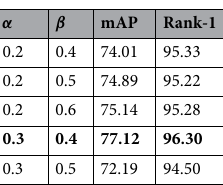
Table 3. The results of different weight coefficient setup. Bold indicate the best results for the corresponding metrics.